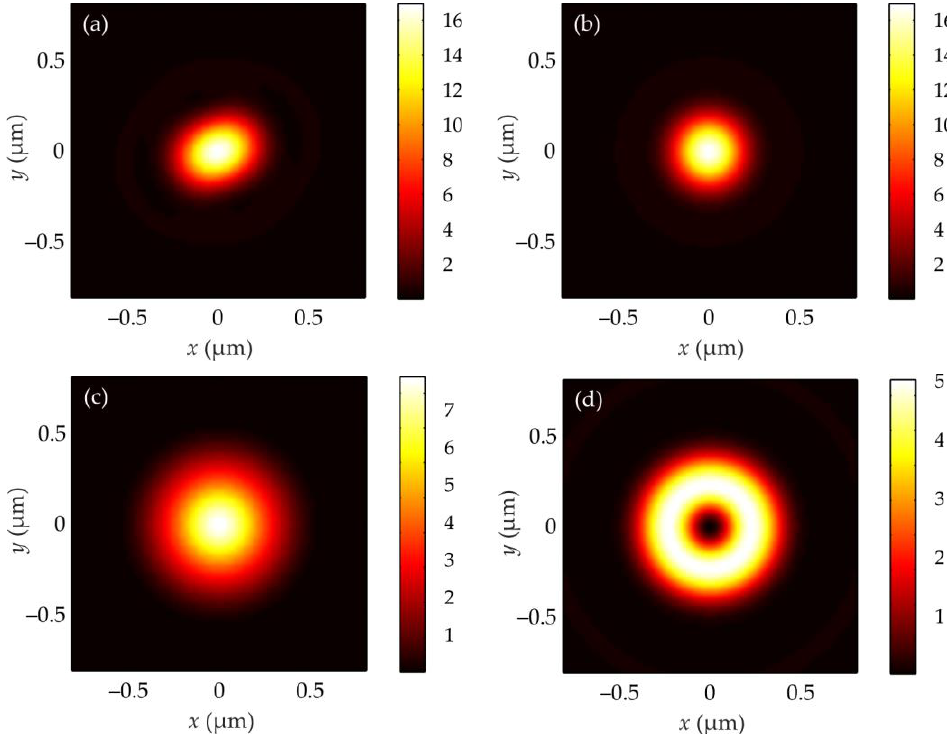
Figure 1. Intensity patterns at the focus for different Poincaré beams of Equation (1): θ = π /4, ψ = π /4, n = 0 ( a ); θ = 0, ψ = π /2, n = 0 ( b ); θ = π /4, ψ = π /4, n = 1 ( c ); θ = 0, ψ = 0, n = − 1 ( d ).